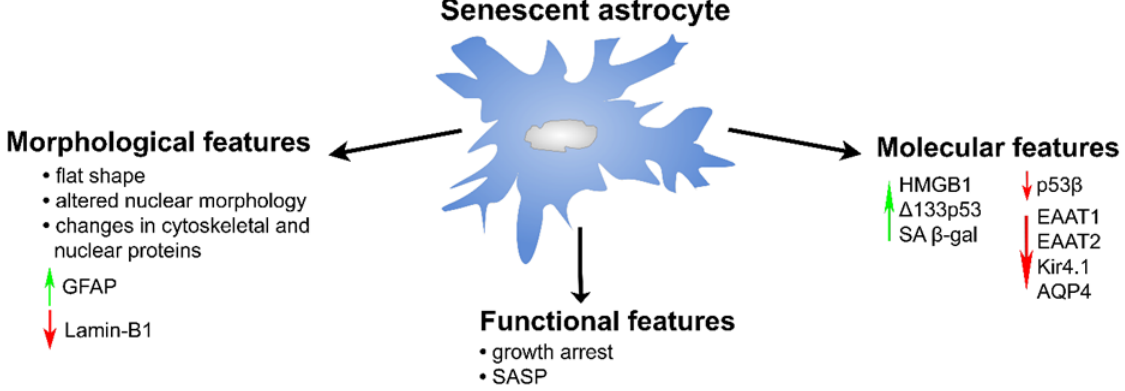
Figure 4. Major morphological molecular and functional features of senescent astrocytes. Senescent astrocytes display an enlarged, flattened cell shape with altered nuclear morphology, accompanied by changes in cytoskeletal and nuclear protein expression, in particular, an increase in glial fibrillary acidic protein (GFAP) and a decrease in Lamin-B1. Senescent astrocytes show the diminished ex- pression of Δ133p53 and increased High-Mobility Group Box 1 (HMGB1) protein, p53β, and senes- cence- associated β -galactosidase (SA ß-gal) activity. The expression of glutamate transporters (EAAT1/EAAT2), potassium channel (Kir4.1), as well as water transporter AQP4 are all down-reg- ulated. Complex morphological and molecular alterations provide predispositions for the adoption of the main senescence characteristics: growth arrest and the senescence-associated secretory phe- notype (SASP) secretome.